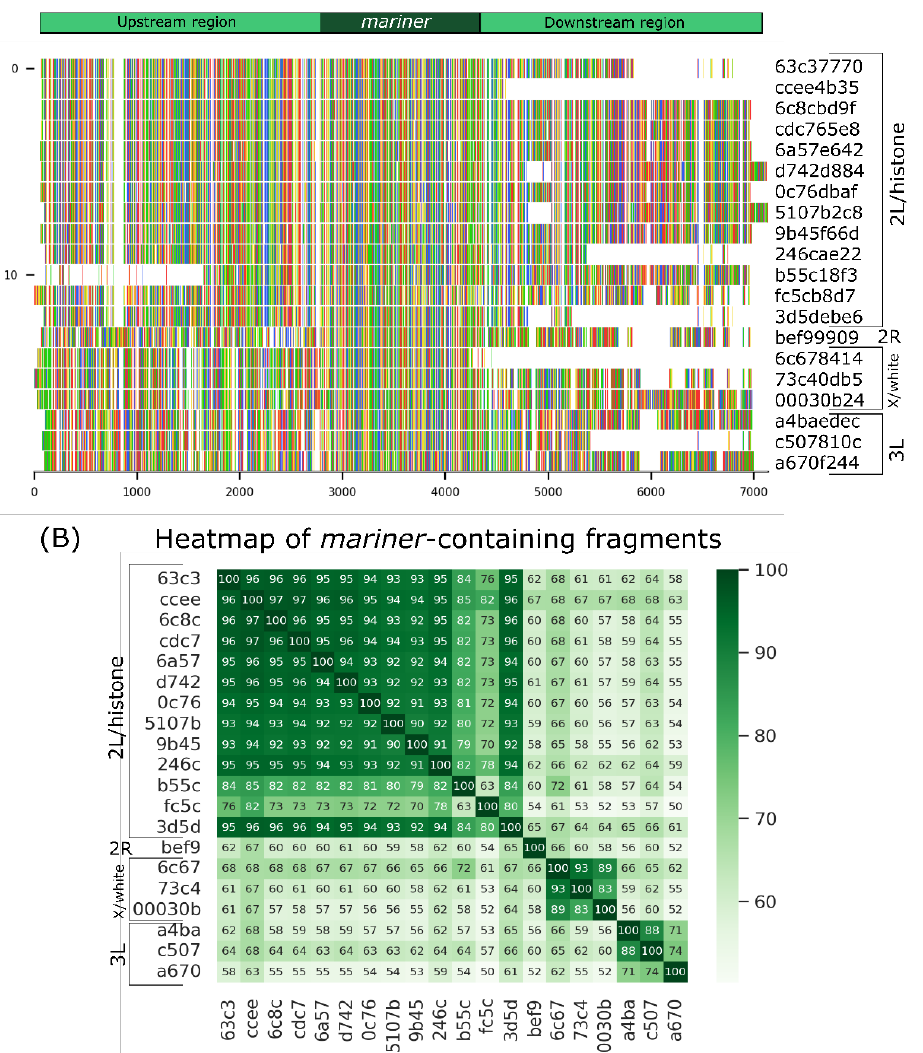
Figure 5. Alignment of mariner -containing long-read fragments and sequence similarity. ( A ) mariner is located in the central region of the figure, with 2 kb upstream and downstream of the element. The first 13 sequences are similar to each other and to chromosome 2L/ histone genes: sequence 14 matches chromosome 2R, 15 – 17 match the X chromosome/ white gene, and 18 – 20 match chromosome 3L. ( B ) Heatmap shows the similarity between sequences and delineates the most similar sequences in darker green. The 4 groups are highlighted, indicating the 4 different regions of the genome where the sequences aligned.